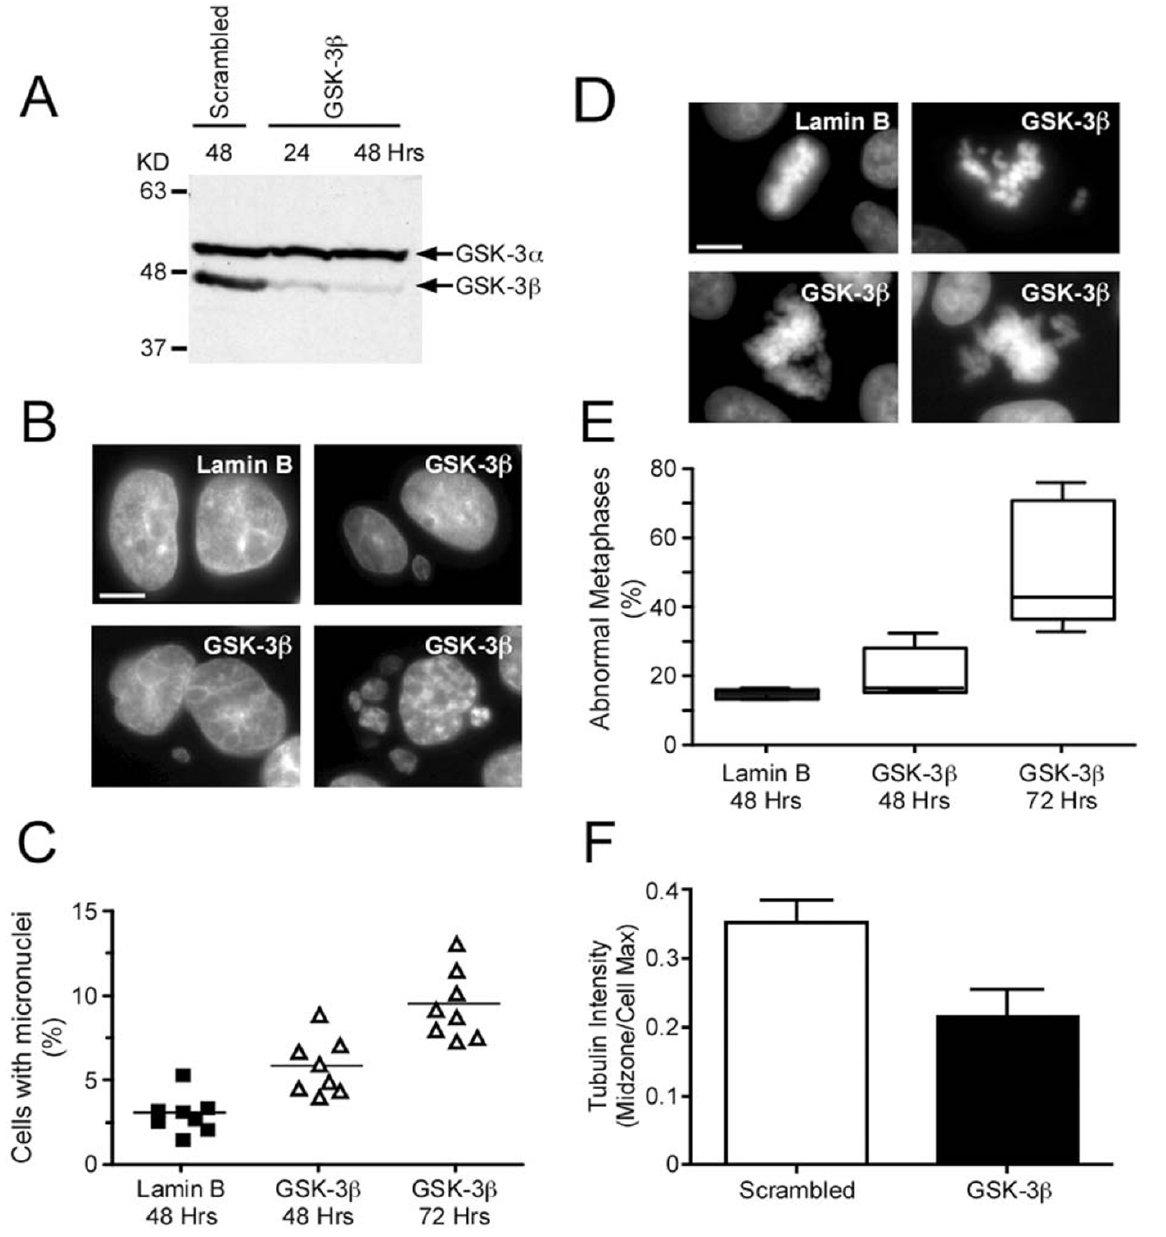
Figure 8 GSK-3 β RNAi inhibits chromosome alignment . DLD-1 cells were transfected with siRNA duplexes designed to repress GSK-3 β then analysed by immunoblot and immunofluorescence. ( A ) Immunoblot showing repression of GSK-3 β . ( B ) Images of interphase cells showing micronuclei following repression of GSK3- β . ( C ) Scatter plot quantitating cells with micronuclei. The data is derived from four independent experiments, with each symbol representing an individual coverslip from which a mini- mum of 1,000 cells was counted. ( D ) Images of mitotic cells showing chromosome alignment defects in GSK-3 β deficient cells. Bar = 5 µ m. ( E ) Box plot quantitating abnormal metaphases in control (black bar) and GSK-3 β RNAi (white bar) populations, 48 and 72 hours after transfection. The data is derived from three independent experiments. (F) Bar graphs quantifying the tubulin intensity at the spindle midzone. Values represent the mean and s.e.m. derived from at least 5